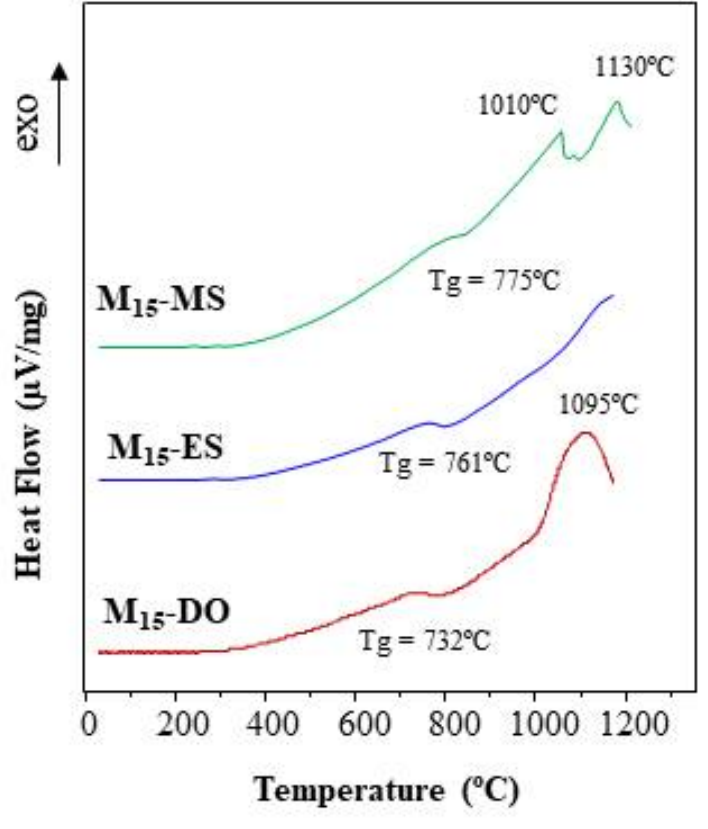
Figure 10. DTA curves of glasses prepared by CSE.